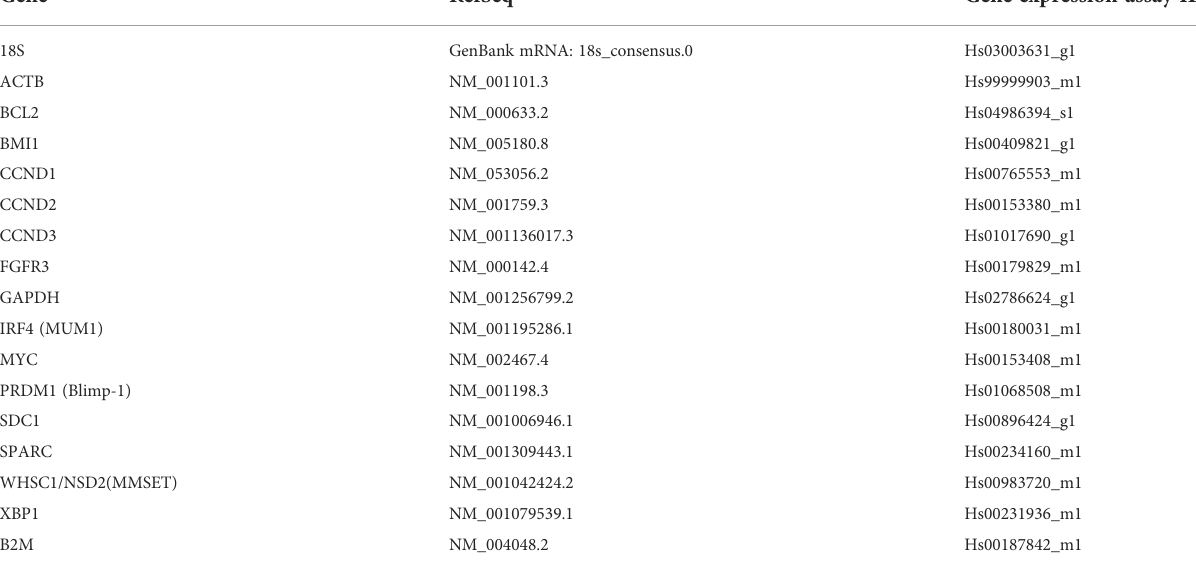
TABLE 1 TaqMan primers and probes used for qPCR performed in this study. Gene